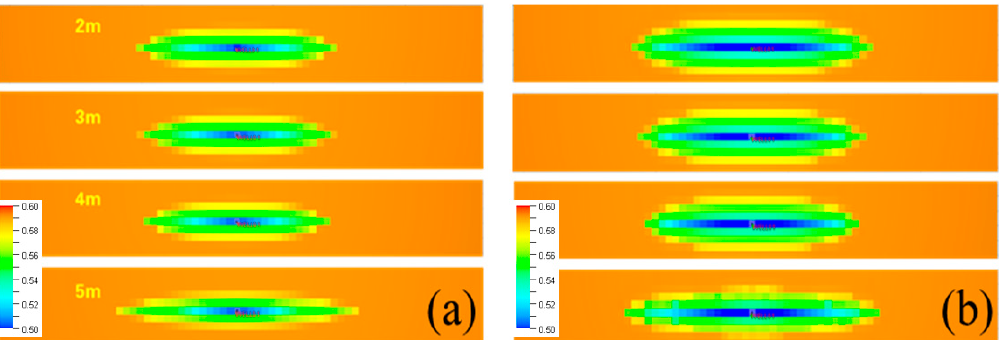
Figure 15. Planar oil saturation distribution with different payzone thickness values. ( a ) After fracturing; ( b ) after 6 years of production.